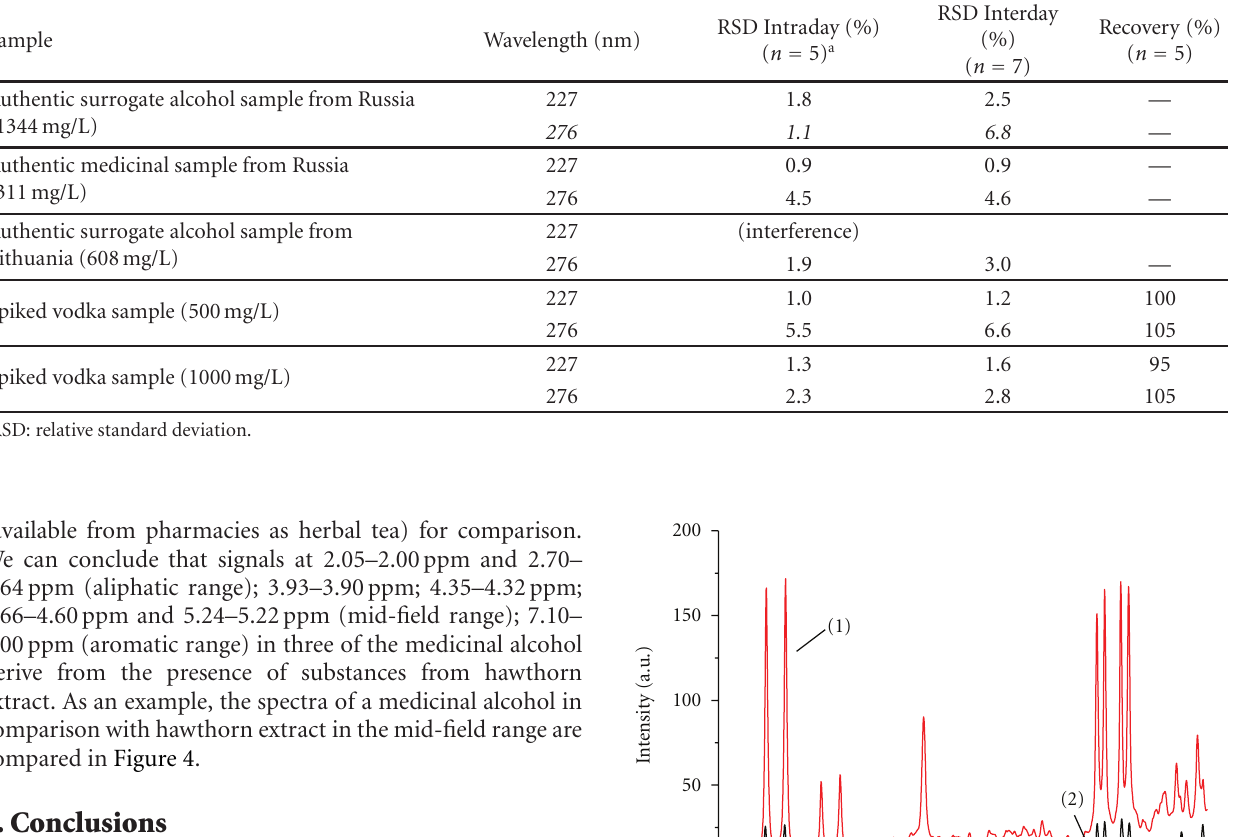
Table 3: Precision and accuracy of the UV/VIS method for analyzing DEP in alcohol samples.